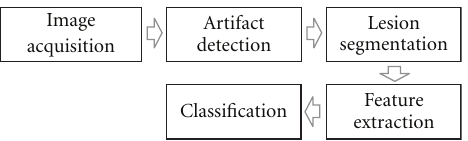
Figure 1: Typical computer aided diagnosis (CAD) pipeline usually adopted for automated skin lesion diagnosis (ASLD). Our goal is to (1) generalize the artifact detection, segmentation as well as a portion of the feature extraction stage into a single mathematical framework and (2) propose and evaluate probabilistic models which employ supervised learning to quickly and automatically “learn” to perform these